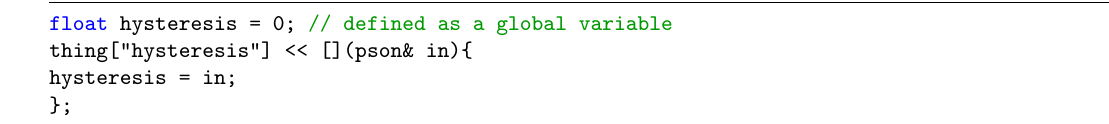
Figure 11. Update sketch variables.